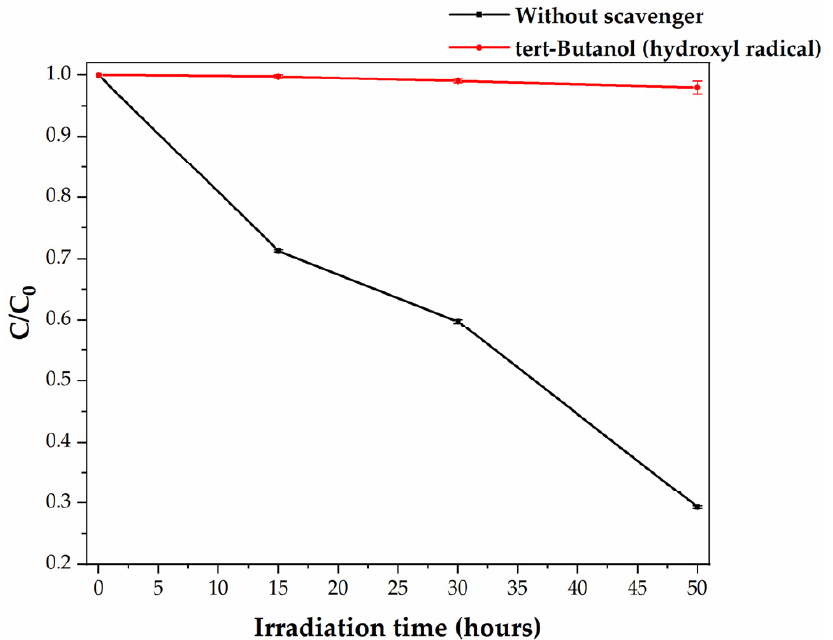
Figure 4. Visible-light photocatalytic degradation of HDPE MPs by C,N-TiO 2 in the absence and presence of tert-Butanol as free OH ● scavenger.